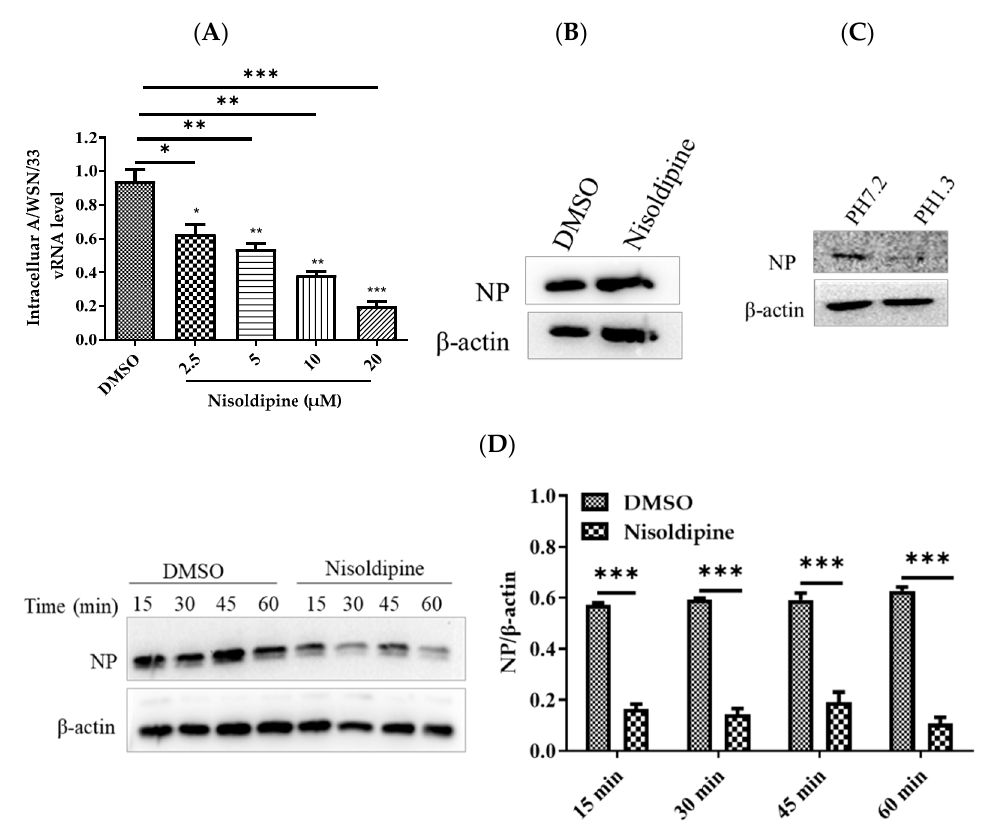
Figure 3. The effect of nisoldipine on viral internalization. ( A ) Nisoldipine acted in the pre-fusion phase of influenza A virus. A549 cells were treated with nisoldipine and then infected with IAV in the presence of ammonium chloride. At 24 h post infection, the cells were lysed to extract RNA, and the relative vRNA level of internalized IAV was measured. ( B ) Nisoldipine has not affected the adsorption of influenza A virus. A549 cells were pretreated with nisoldipine or DMSO for 3 h and then infected with IAV (MOI = 5) on ice at 4 ◦ C for 1 h. The cells were lysed with RIPA and then subjected to Western blotting with a rabbit anti-NP pAb. ( C ) A549 cells were infected with A/WSN/33 (MOI = 5) on ice at 4 ◦ C for 1 h, followed by ice-cold PBS (pH 7.2) or PBS-HCl (pH 1.3) before cell lysis. Viral NP protein expression was detected by Western blotting. ( D ) Nisoldipine could interfere with the internalization stage of the virus. A549 cells were pretreated with 20 µ M nisoldipine or DMSO for 3 h and then infected with A/WSN/33 (MOI = 5) at 37 ◦ C. The infected cells were washed with ice-cold PBS-HCl (pH 1.3) at the indicated time points before cell lysis. Viral NP protein expression was detected by Western blotting. Data are presented as mean ± SD (* p < 0.05, ** p < 0.01, *** p <